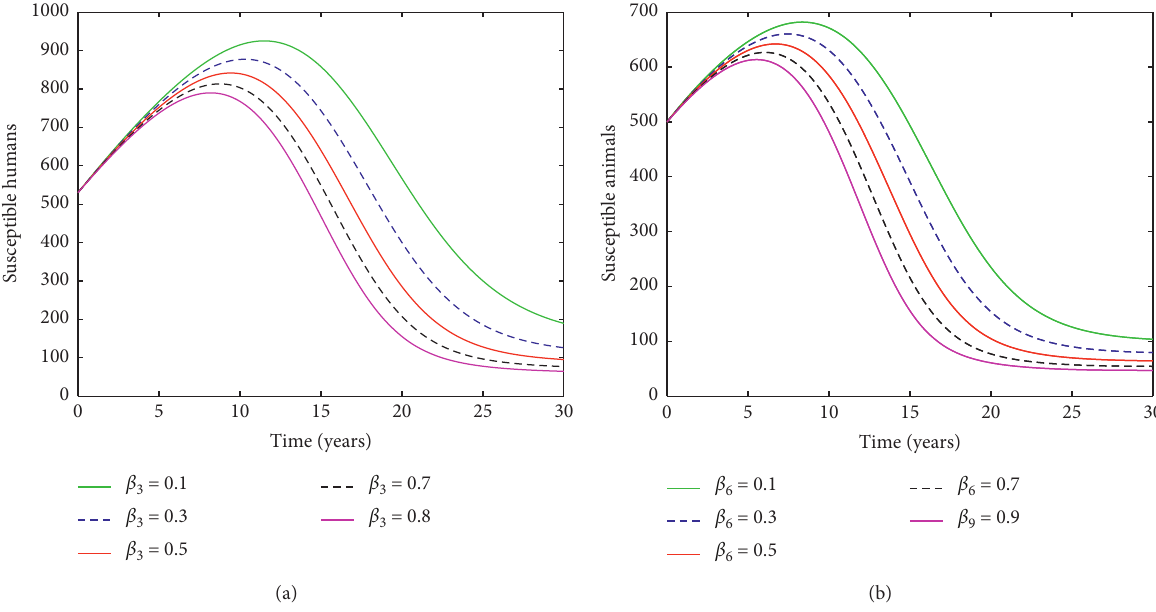
Figure 7: The impact of rates of transmission form dairy products to susceptible (a) humans and (b) animals.